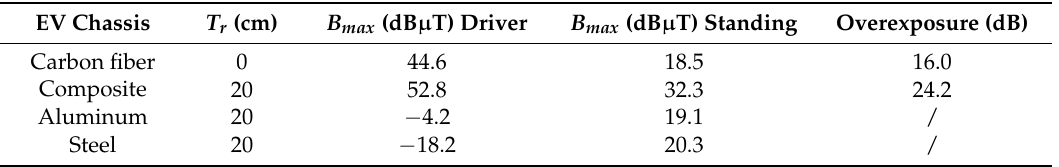
Table 4. Maximum magnetic field for both anatomical models.